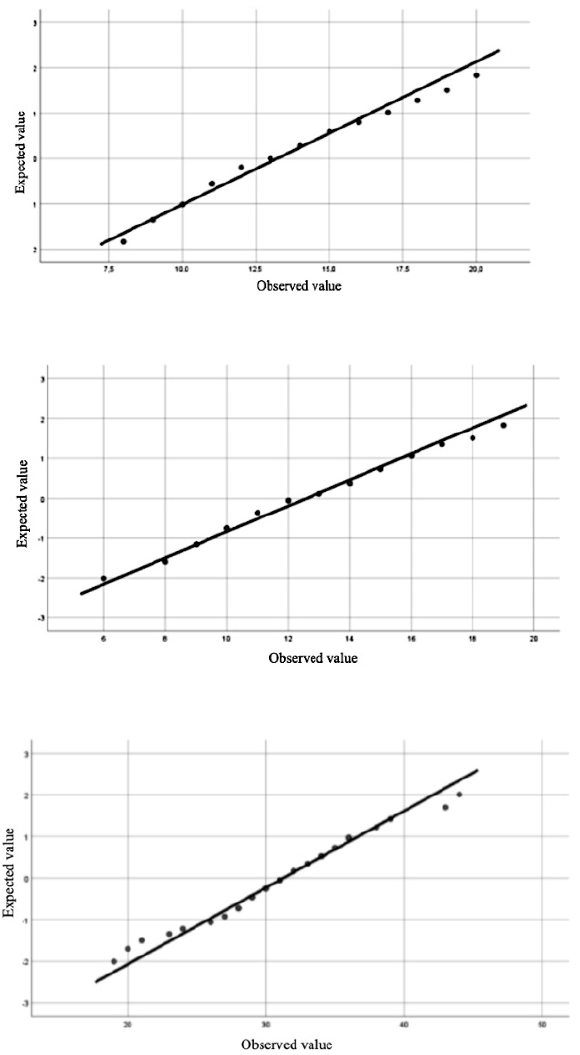
Figure 1. Normality distribution of the ATHRI questionnaire factors. Global sample.